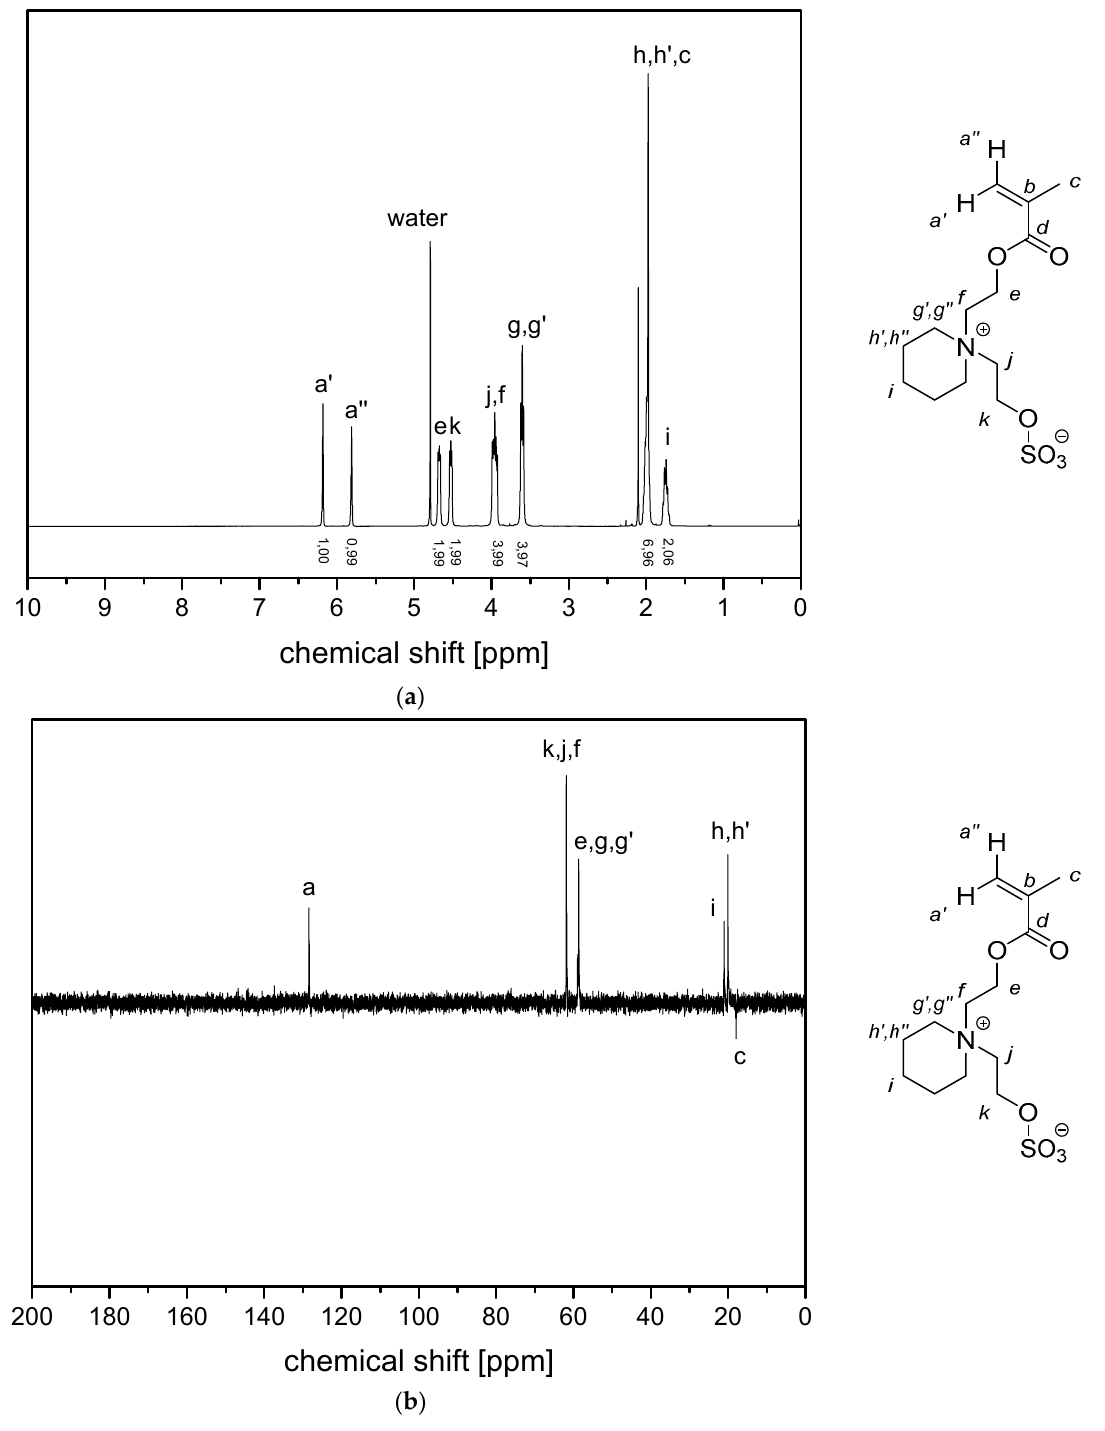
Figure A5. ( a ) 1 H NMR- spectra and ( b ) 13 C (APT) NMR-spectra of monomer 4c in D 2 O.